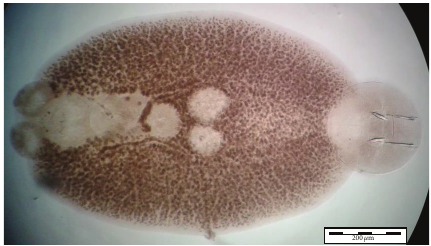
Figure 4: Ventral view of whole Neobenedenia melleni in compound microscope.